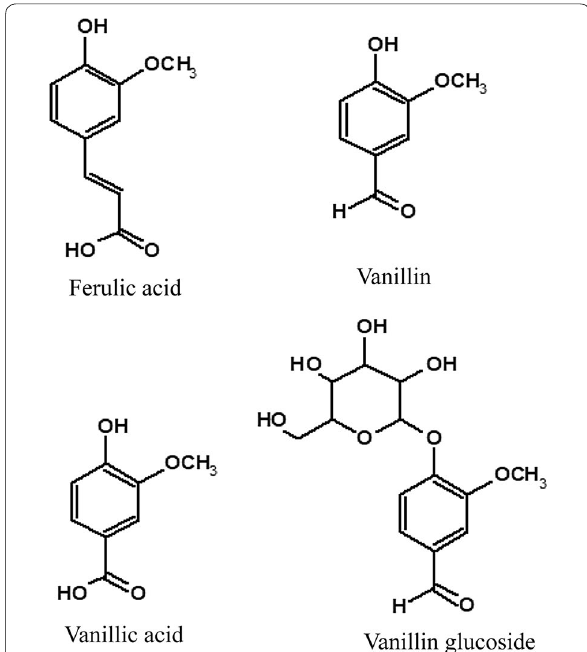
Fig. 1 The phenolic compounds were detected in rice-koji fer- mented by Aspergillus